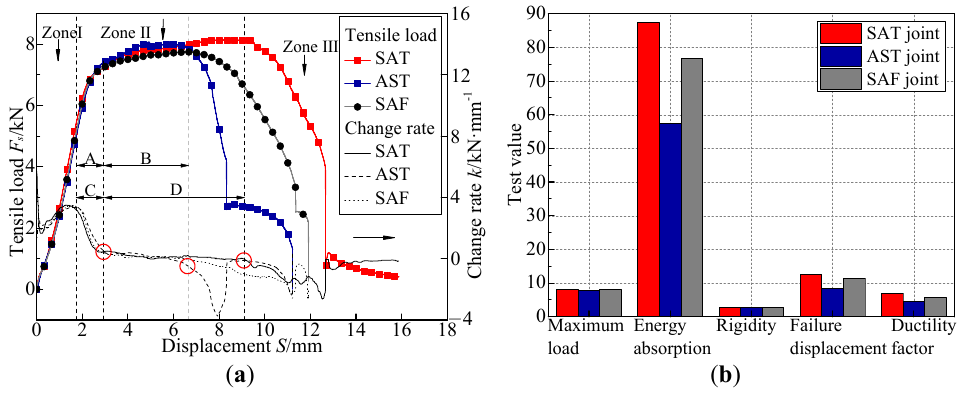
Figure 9. Tensile property of two-rivet joints. ( a ) F s - S curves and k - S curves; ( b ) test values.